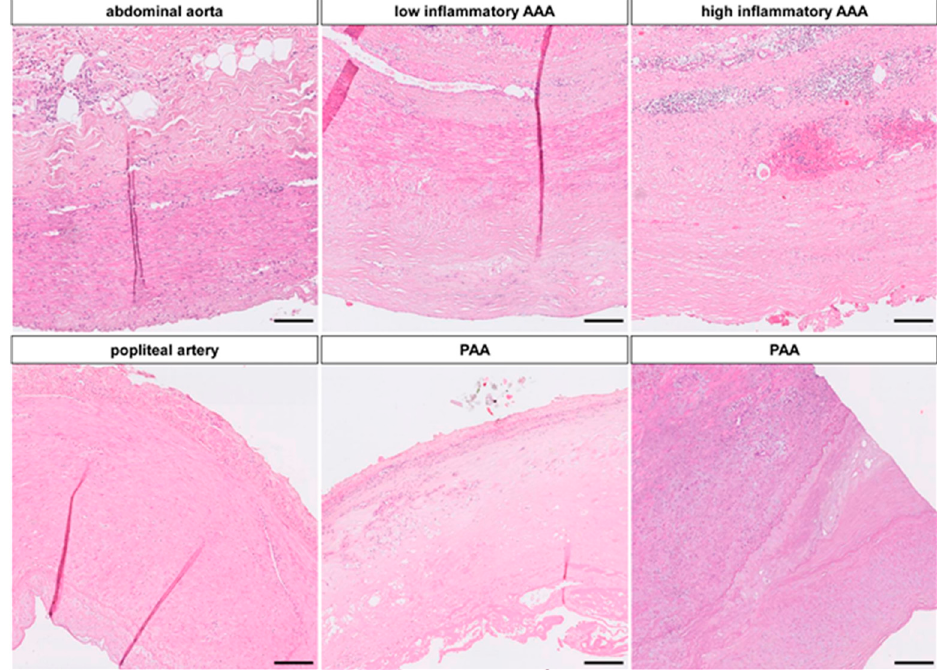
Figure 1. Histologic Scope of Aneurysm Disease: Hematoxylin/Eosin (HE) staining shows the different vessel architecture between elastic (aorta) and muscular (popliteal artery) arteries. The abdominal aorta at the infrarenal position consists of approx. 24 layers of elastic fibers, with a thin endothelium and a clear demarcation to the adventitia with microvasculature, few inflammatory cells and adipocytes, whereas further distally, a single inner and outer elastic lamella make up the margin of the muscular media with contractile vascular smooth muscle cells (VSMC). In aneurysm disease, this morphology changes and the intimal/medial extracellular matrix (ECM) is completely altered by calcification, neoangiogenesis, destruction of elastic fibers, fibrosis and inflammatory infiltration. In aortic aneurysms ( upper panel) these changes vary, especially in terms of inflammation and fibrosis, whereas the popliteal aneurysm (PAA) morphology is more homogenous ( lower panel). (magnification 10×, scale bar 50 µm).